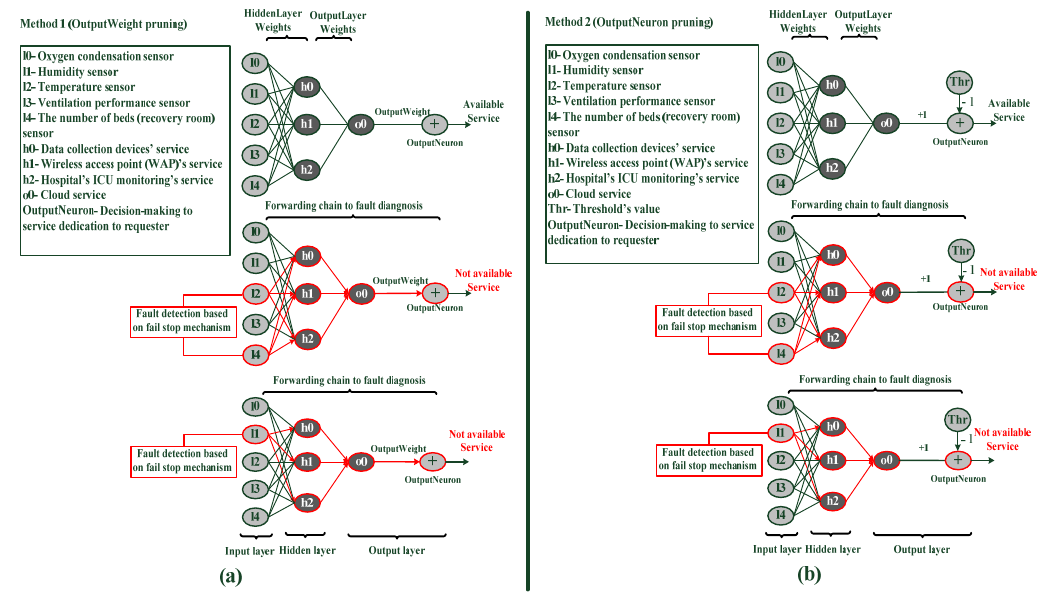
Figure 5. Two different methods to decision-making about dedicating service to a requester with high quality and forwarding chain to fault detection: ( a ) Method 1 based on pruning weak. Weight (output weight) and output neuron in the output layer; ( b ) Method 2 is based on pruning weak output neuron in the output layer .